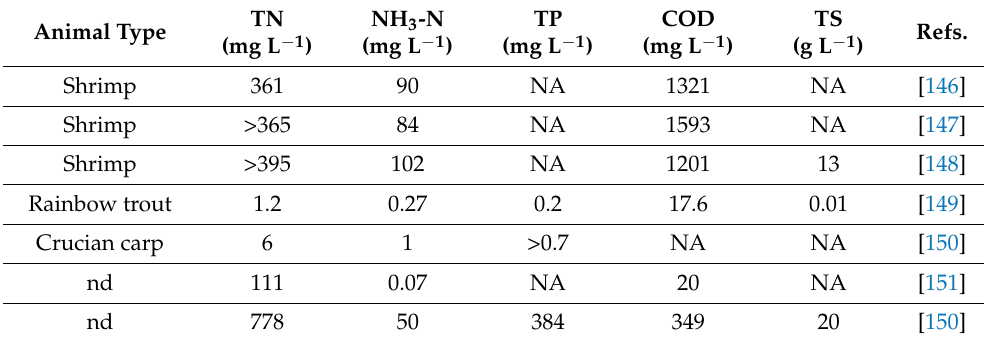
Table 6. Nutrient content of several aquaculture wastewaters *.